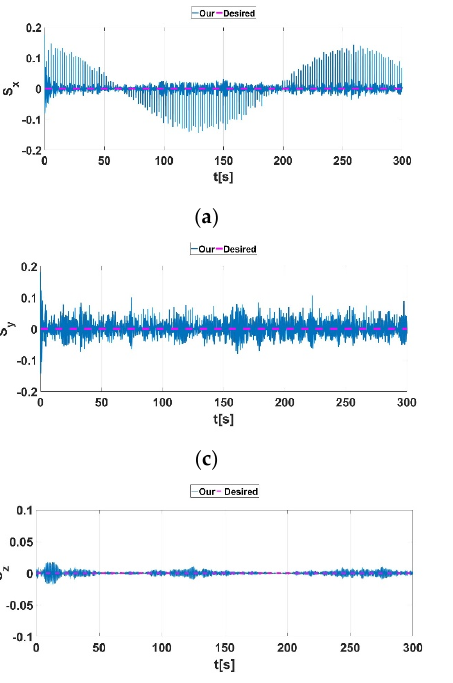
; ( c ) 𝑣 𝑒 ; ( d ) 𝑞 ; ( e ) 𝑤 𝑒 ; (f) 𝑟 𝑒 . 𝑒 𝑒